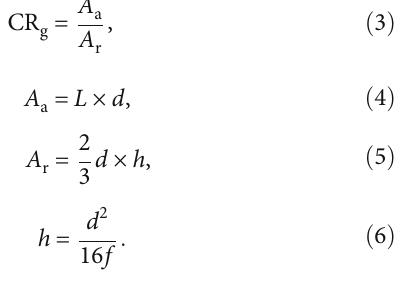
Figure 1: XRD pattern of TiO